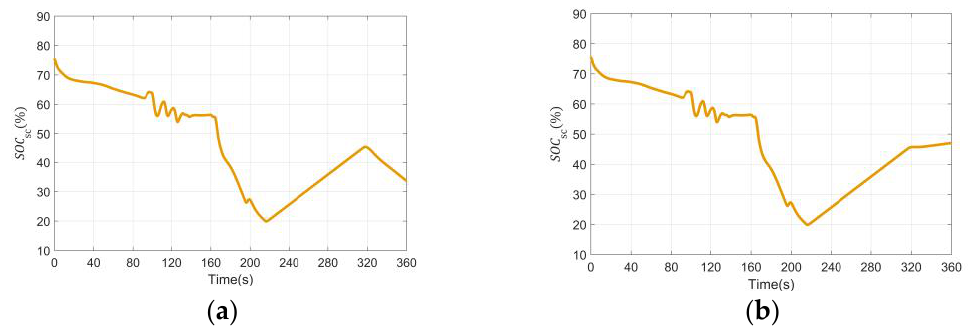
Figure 26. Variation in the SOC value of the supercapacitor with different strategies: ( a ) conventional vessel energy management strategy; ( b ) improved vessel energy management strategy.